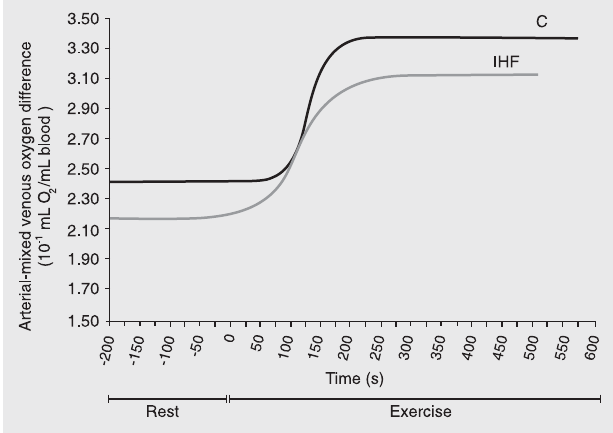
Figure 4. Time course of arterial-mixed venous oxygen difference during progressive exercise in normal control (C) and ischemic heart failure (IHF)